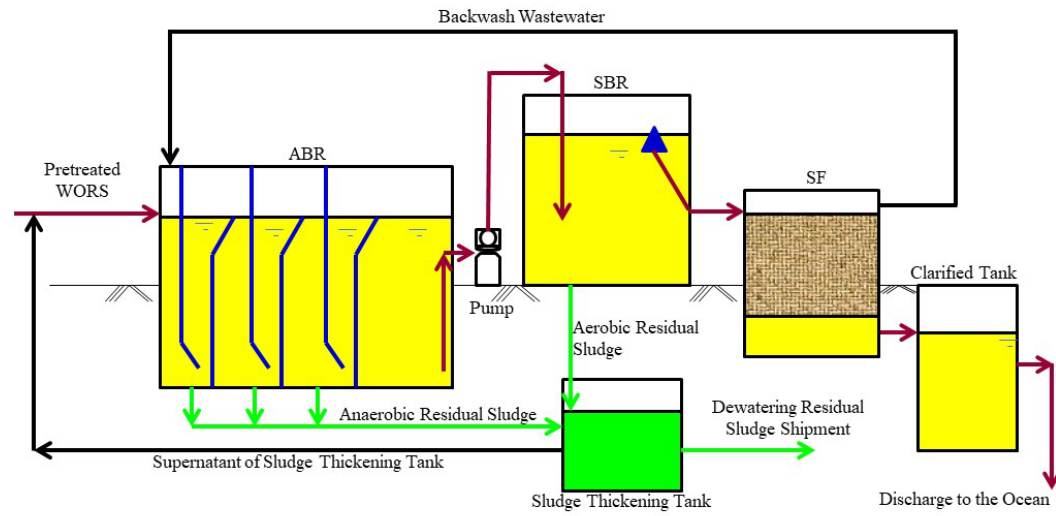
Figure 2. WORS treatment processing flow chart (ABR: anaerobic baffle reactor; SBR: sequencing batch reactor; SF: sand